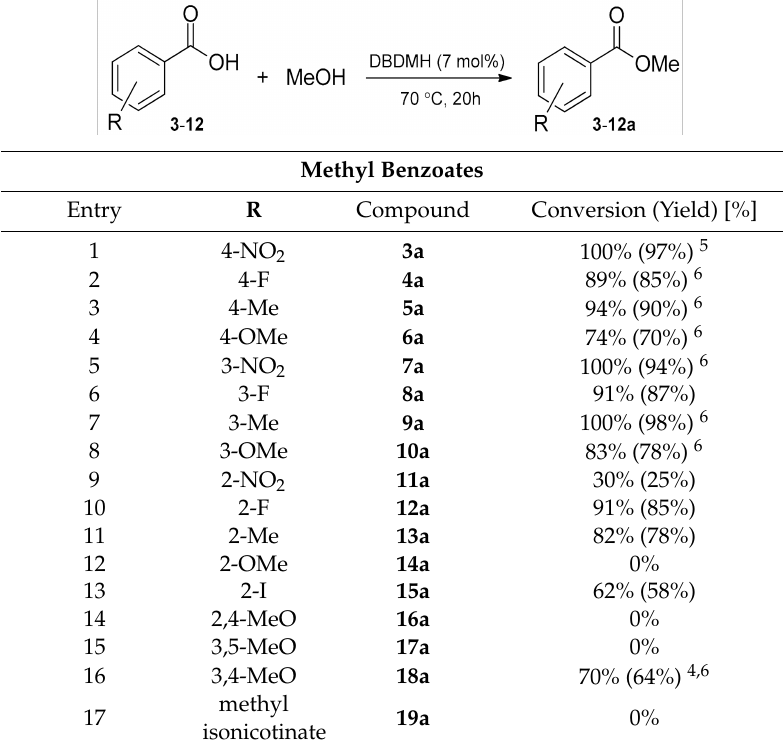
Table 4. Scope width of aromatic carboxylic acids tested under optimized esterification conditions 1,2,3